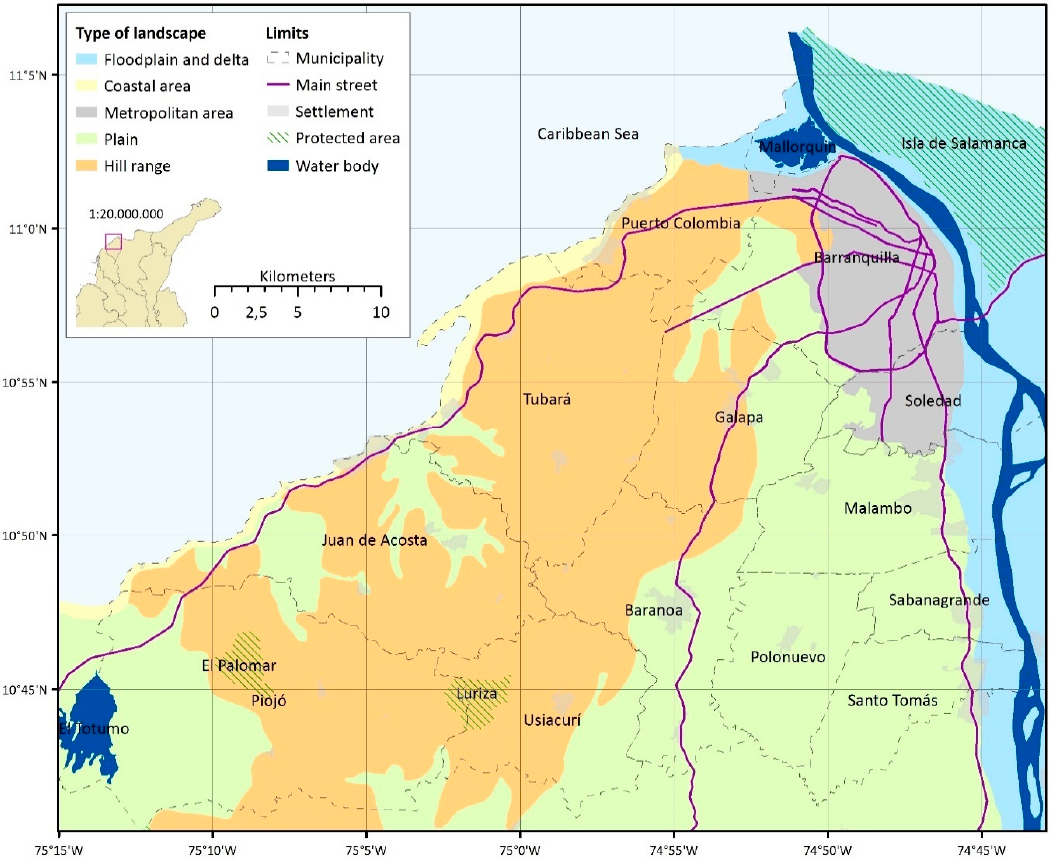
Figure 1. Study area: the hinterland of Barranquilla with settlement structures, administrative and landscape division.